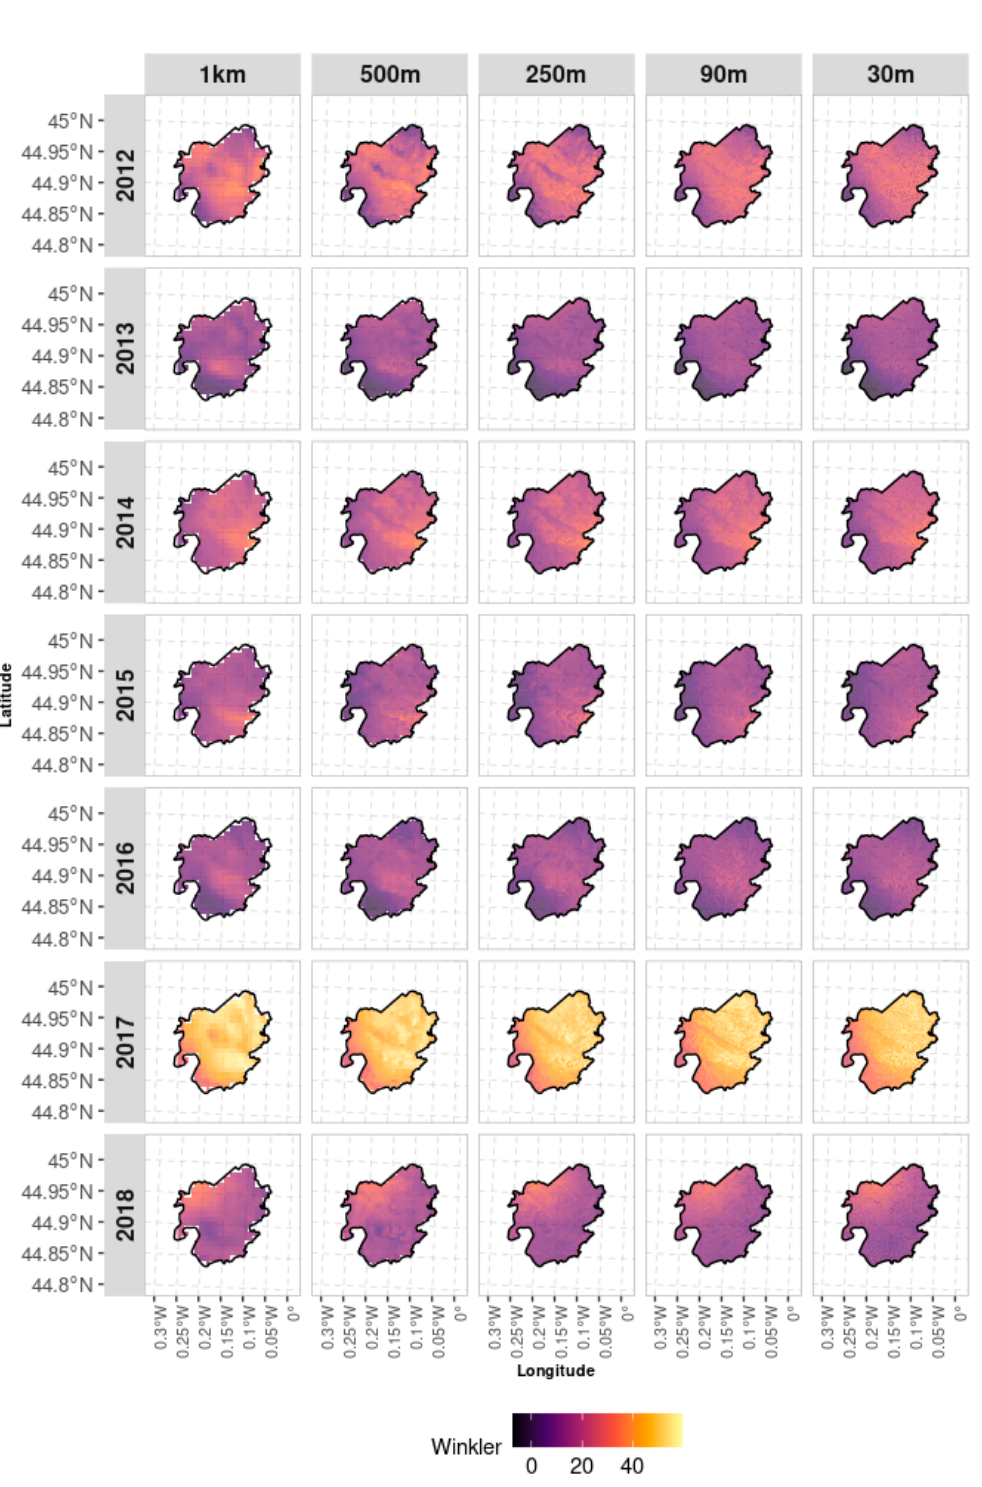
Figure A1. Spatial distribution of differences in the Winkler bioclimatic index calculated from daily land surface temperature (M*11A1) minus that calculated from the 8-day land surface temperature (M*D11A2) from 2012–2018 and gridded at different spatial resolutions.